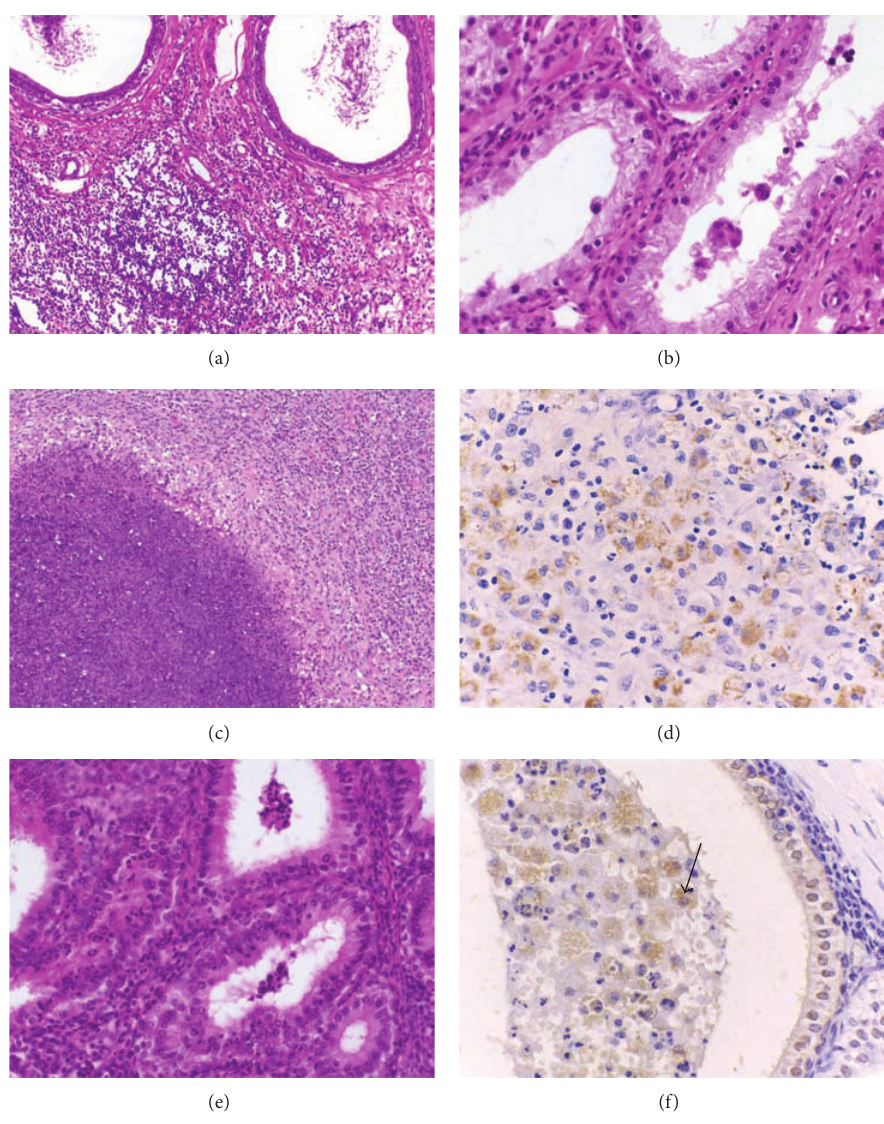
Figure 7: Microscopic findings in rams experimentally infected with Actinobacillus seminis . (a) Tail of the epididymis, focal severe mononuclear interstitial infiltrate, HE 200x. (b) Testis, intense degeneration with reduction of seminiferous epithelium layers, HE 400x (c) Tail of the epididymis, sperm granuloma, HE 200x. (d) Tail of the epididymis, and immunostained bacteria within the cytoplasm of cells in the granuloma, streptavidin-peroxidase 600x. (e) Seminal vesicle, interstitial and intraluminal inflammatory infiltrate, HE 400x. (f)